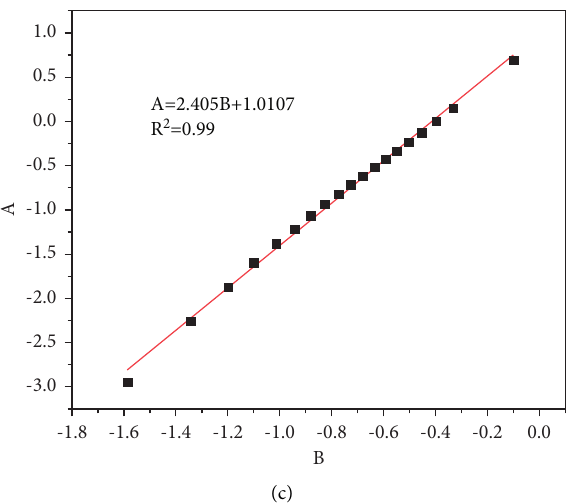
Figure 2: Fractal analysis of the CO